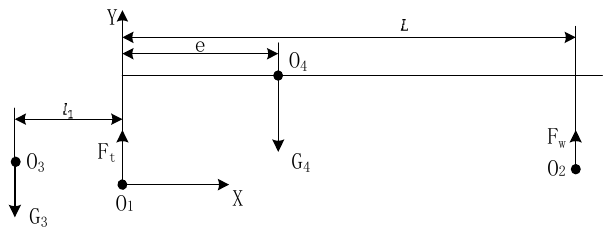
Figure 2. Force analysis of rape windrower on flat road.